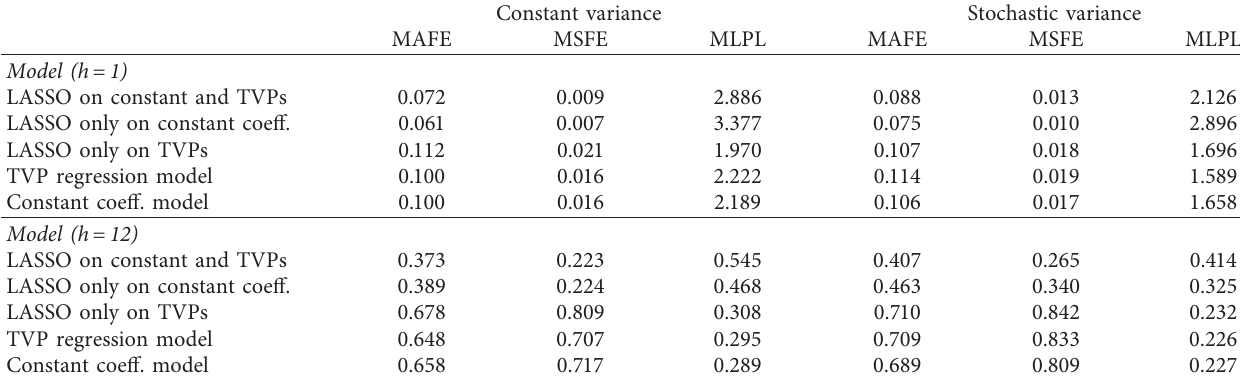
Table 6: Measures of forecast performance for log return of Brent with the full models. Constant variance